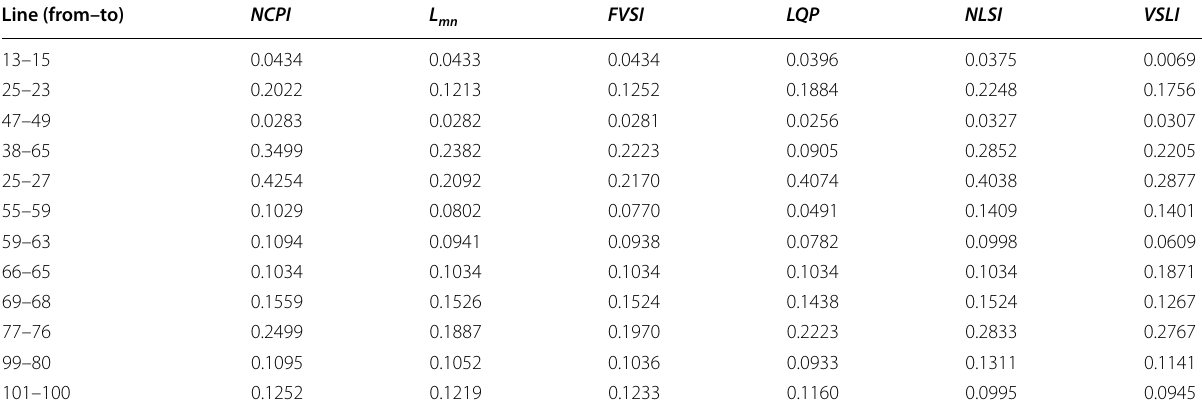
Table 5 The line stability indices for the IEEE 118-bus for the base case loading Line